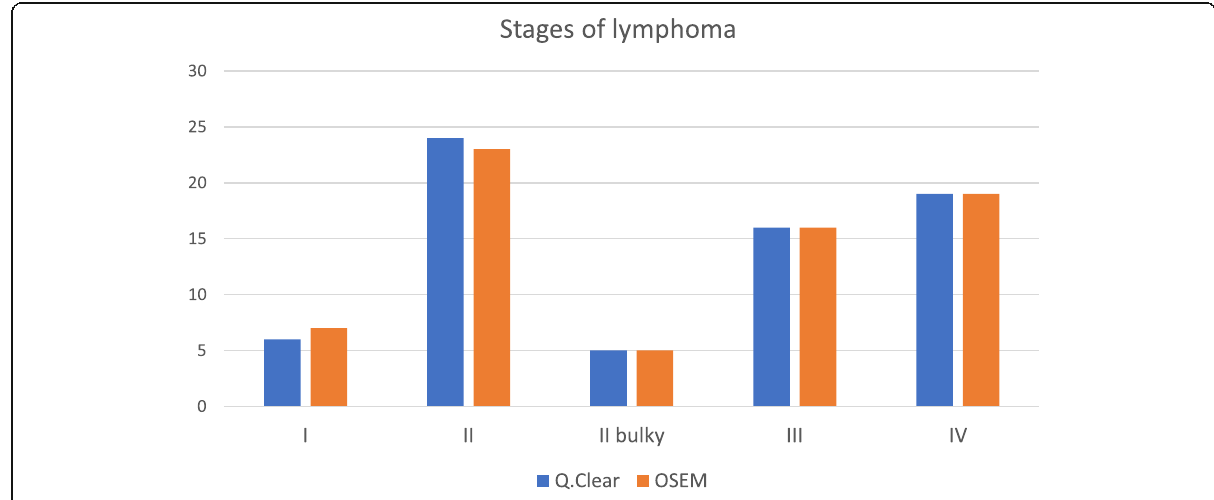
Fig. 1 Number of patients with each stage of lymphoma as assessed by two reconstruction algorithms — Q.Clear and OSEM